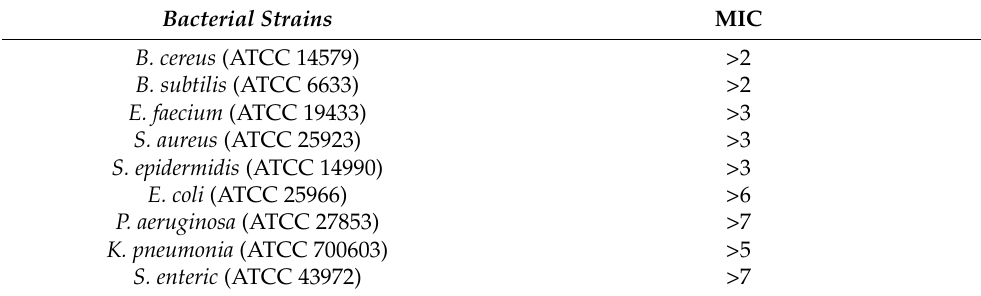
Figure 5. Antibacterial properties of the alpha amylase inhibitor ( α AI.Mol) from Moringa oleifera) . The antibacterial effect was evaluated against several Gram-positive and Gram-negative bacteria presented by zone of inhibition (mm) using pure amylase inhibitor (gray bars) and crude extract (black bars). Table 4. Antimicrobial activity of α AI.Mol on bacterial strain MIC